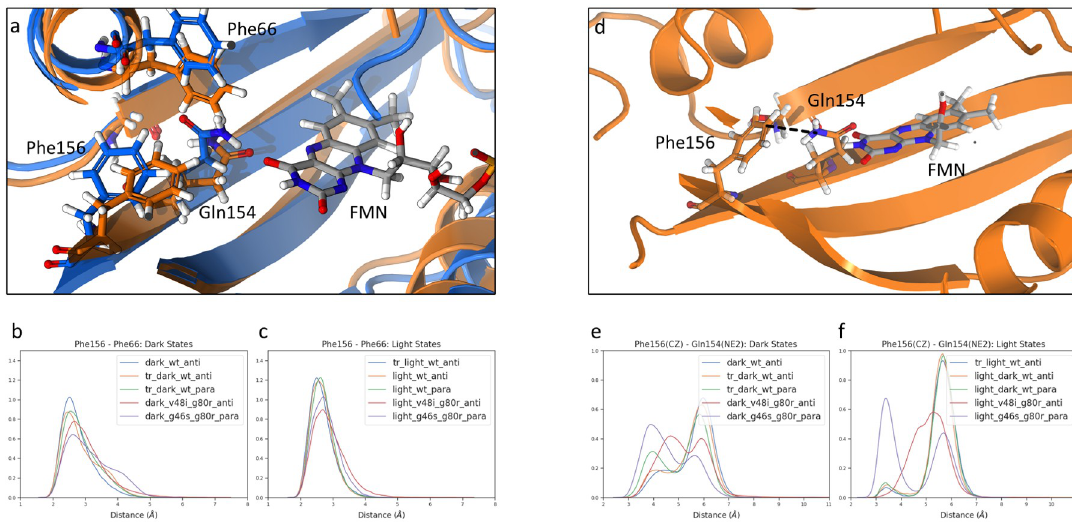
Fig 4. Phe156 stabilization factors for WT and G46S:G80R mutant. a) Structure of π -stacking interaction between Phe156 and Phe66 found in WT structures. Dark state is represented in blue, and light state is represented in orange. b) Distribution of Phe156 and Phe66 distance for ZTL structures in the dark state. c) Distribution of Phe156 and Phe66 distance for ZTL structures in the light state. d) Illustration of interaction between Phe156 CZ and Gln154 NE2 found in G46S:G80R structures. e) Distribution of Phe156 CZ and Gln154 NE2 distance for ZTL structures in the dark state. f) Distribution of Phe156 CZ and Gln154 NE2 distance for ZTL structures in the light state.